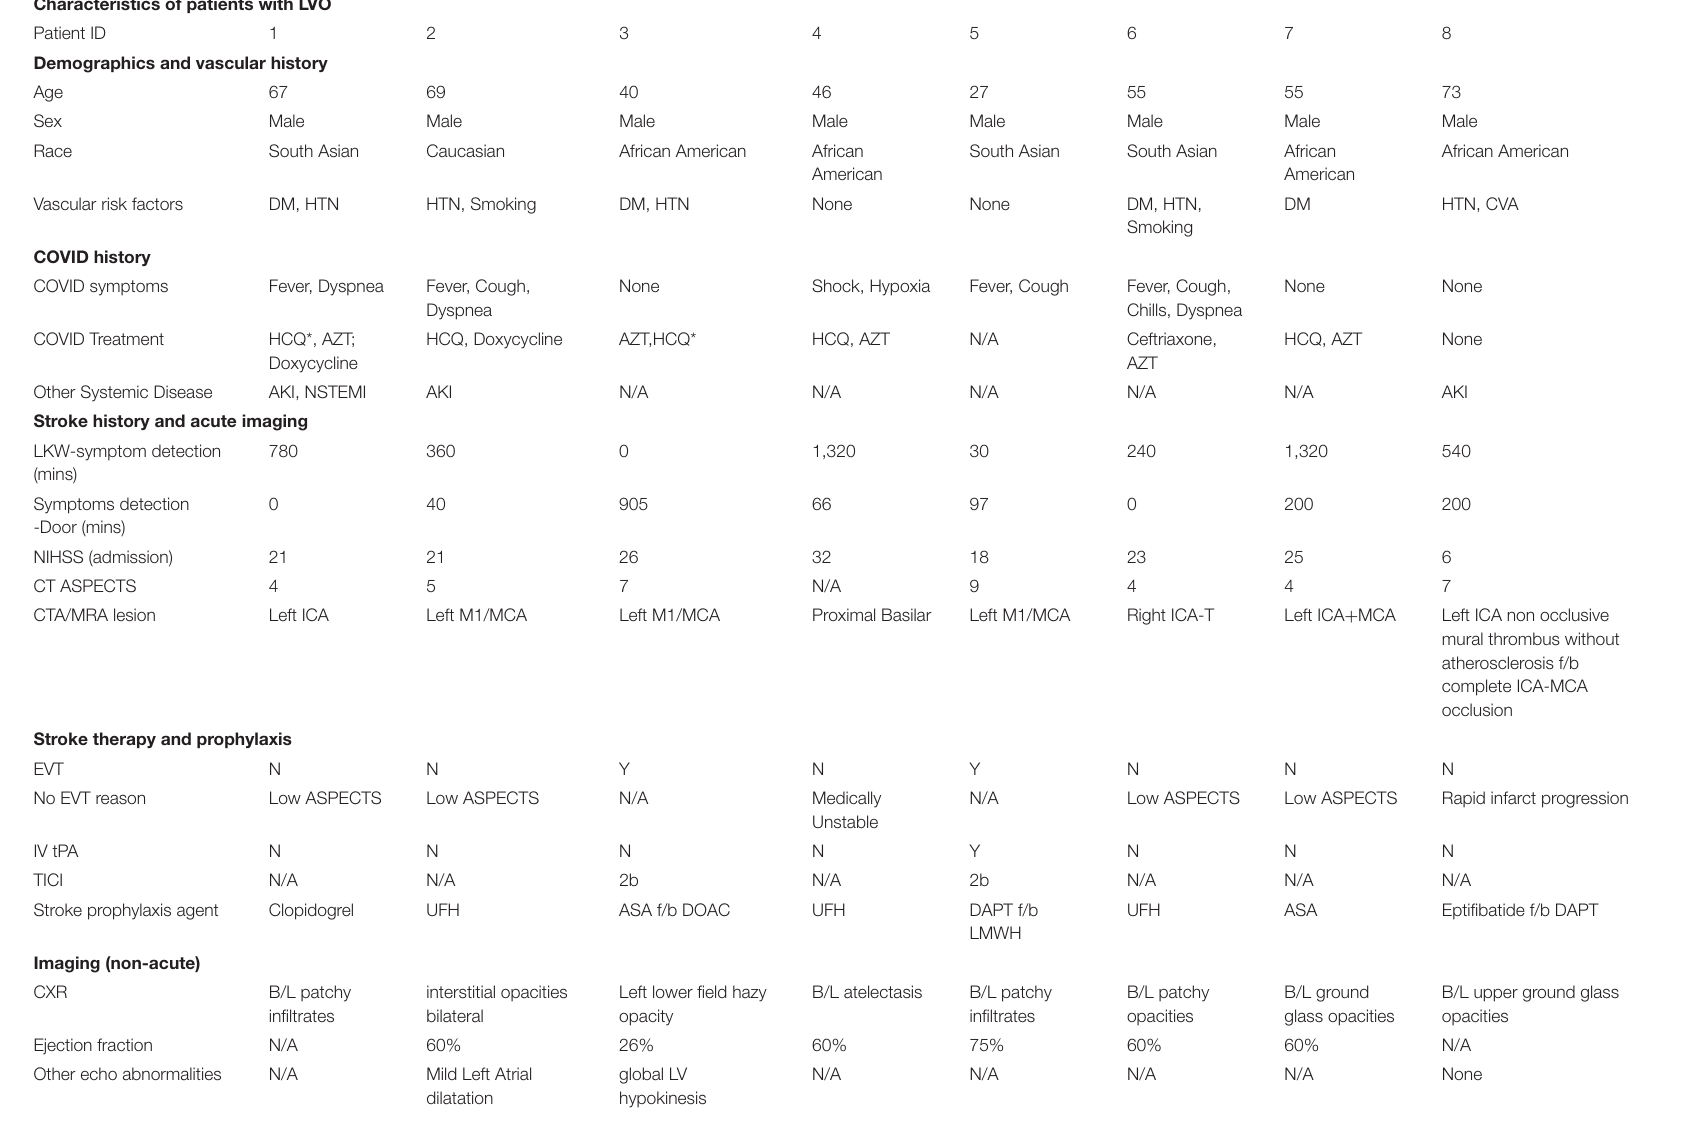
TABLE 1 | Patient with large vessel occlusion (LVO)